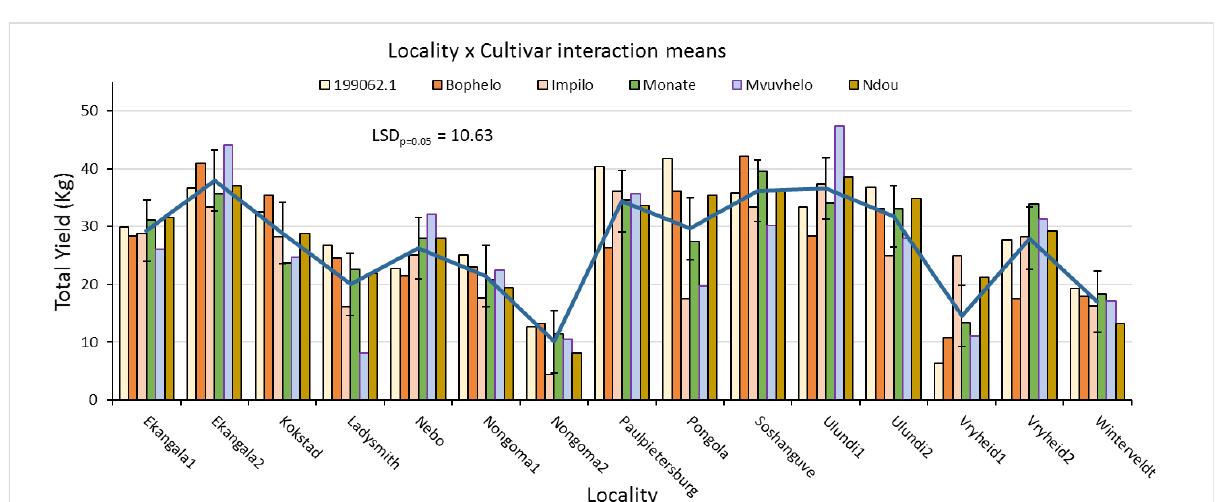
Figure 1: Locality by cultivar interaction means for total yield for six cultivars by 15 on-farm trials